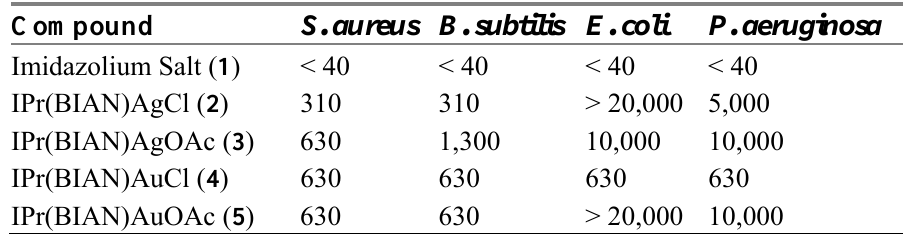
Table 3. Minimum inhibitory concentrations (MIC) for compounds 1 - 5 in μ